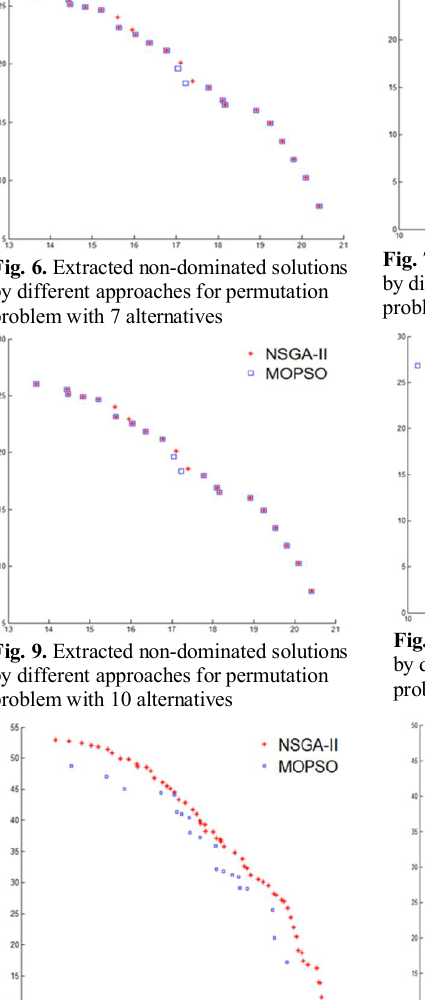
Fig. 14. Extracted non-dominated solutions by different approaches for permutation problem with 15 alternatives